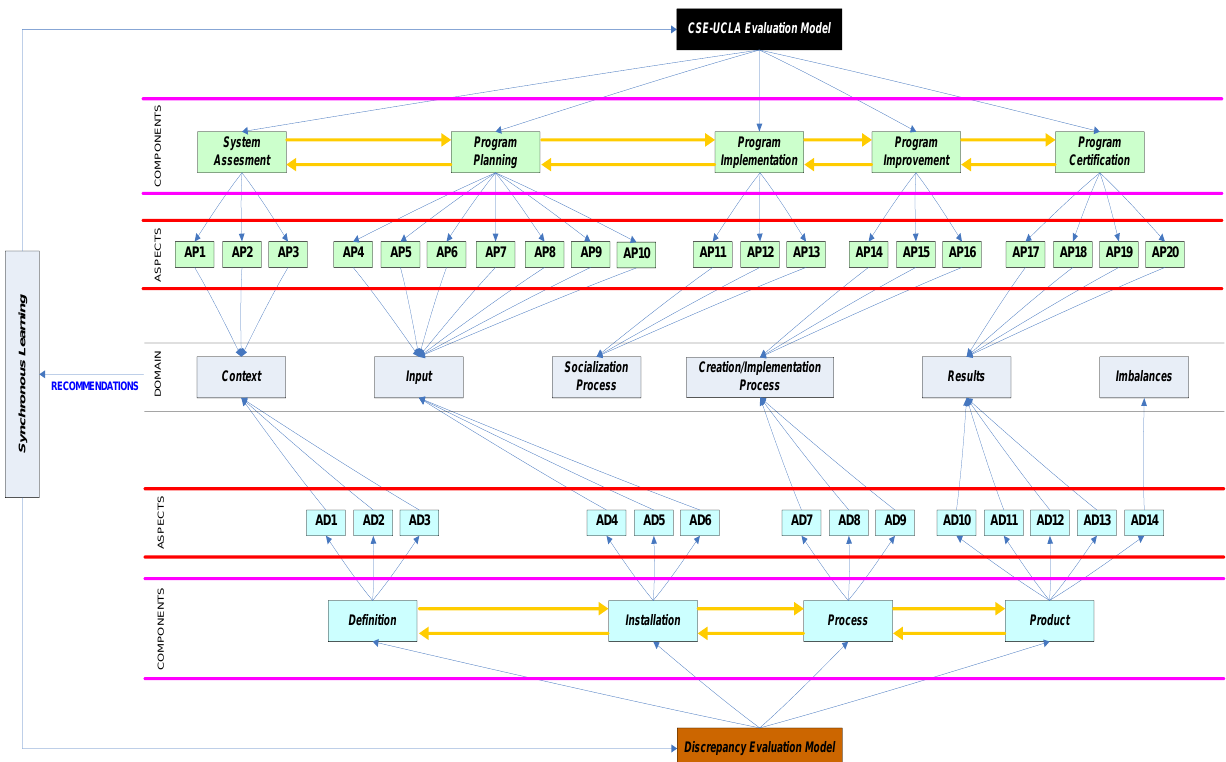
Figure 4. The Modified Design of the CSE-UCLA Model and Discrepancy Model was obtained from the Revision Results based on the Respondents’